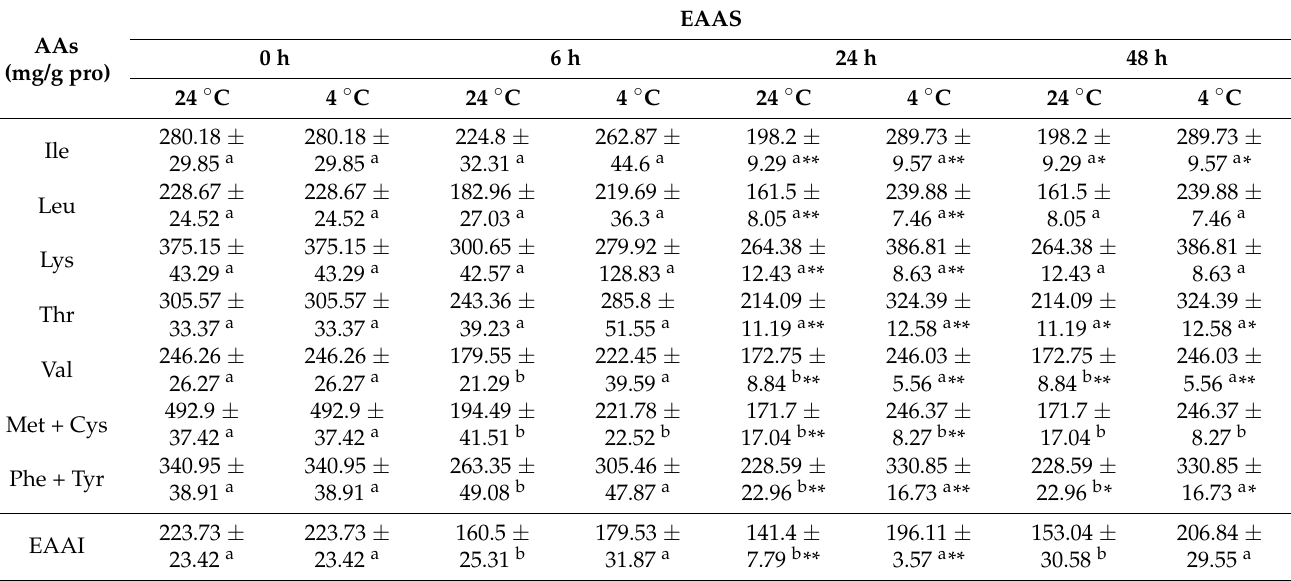
Table 7. Essential amino acids score (EAAS) and essential amino acids index (EAAI) content of